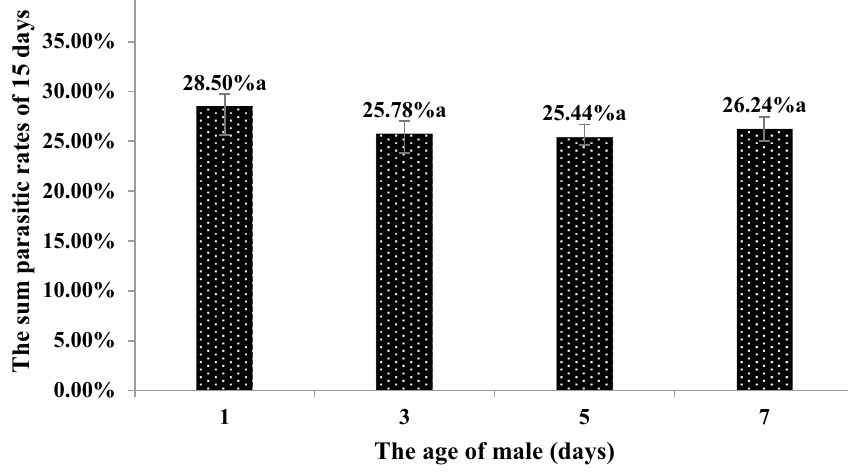
Figure 11. The parasitic rates of females C. japonicus at different male ages. Data in the figure are mean ± standard error, different letters indicate significant differences in Duncan’s test, with a probability of 5%.